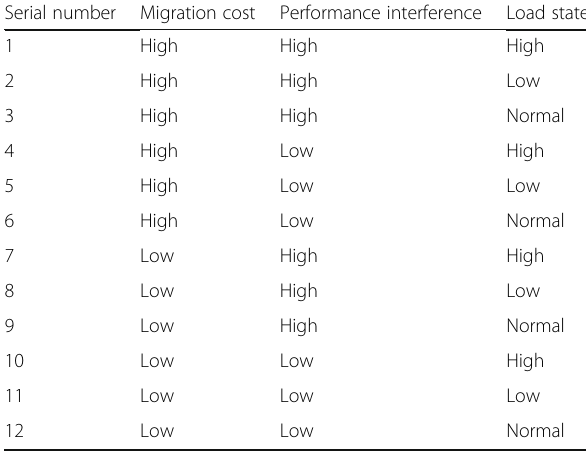
Table 1 Virtual machine classification Serial number Migration cost Performance interference Load